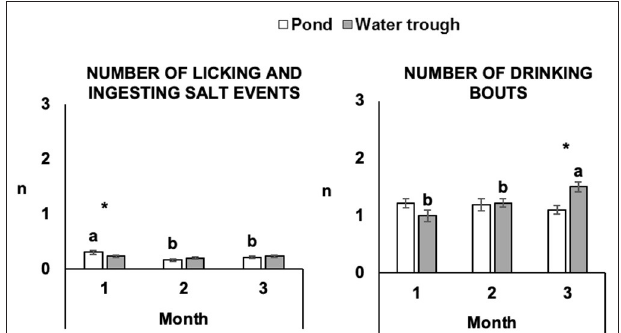
FIGURE 2 | Effect of treatment and period on the number of events of animal licking and ingesting salt and number and duration of drinking bouts. The number of events of animal licking and ingesting salt and drinking bouts is expressed in least square means of the number of events per animal per period of observation. The duration of drinking bouts is expressed in least square means of the duration (s) of events per animal per treatment or period of observation. Different letters “a, b” represent significant differences ( P ≤ 0.05) between periods of observation within treatment. “*” represents significant differences ( P ≤ 0.05) between treatments within the period of observation.